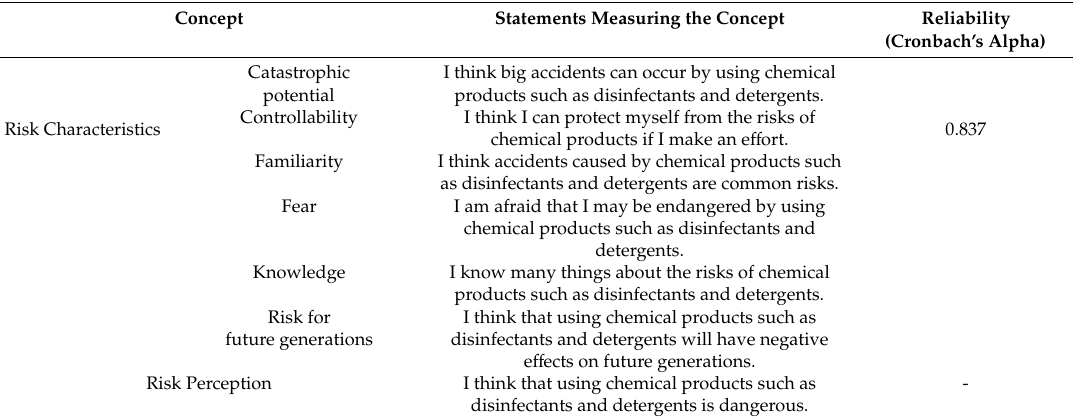
Table 1. Research concepts: risk characteristics and